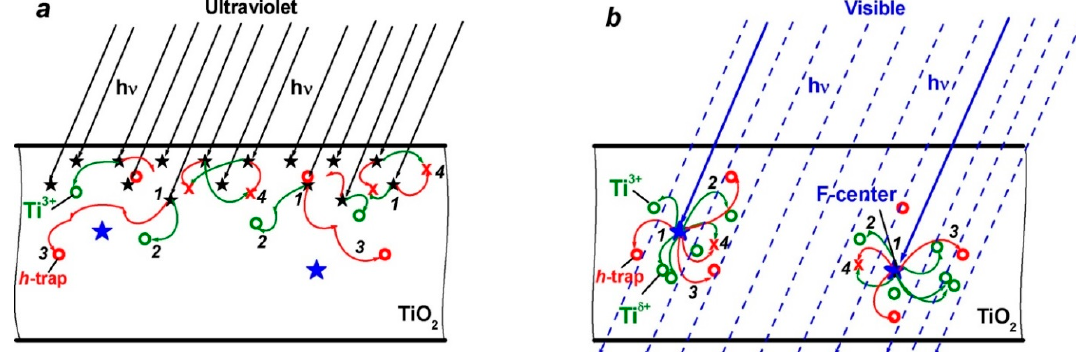
Figure 61. Illustration of the absorption of light quanta and formation of: ( 1 ) electron–hole pairs; ( 2 ) electron; and ( 3 ) hole transport and their localization at traps; together with ( 4 ) electron–hole recombination under: ( a ) UV irradiation; and ( b ) Vis-light irradiation of a microcrystalline particle of VLA TiO 2 . In ( a ), the black stars denote the photogenerated electron–hole pairs, the blue stars the F -type centers (electron trapped in oxygen vacancy); the green circles the Ti 3+ color centers, while the red circles refer to the trapped holes. In ( b ), the blue stars denote the F -type centers (electron trapped in oxygen vacancy), the green circles the Ti 3+ color centers, while the red circles denote the trapped holes. Note the Ti δ + centers in ( b ). Reproduced with permission from Kuznetsov et al. [70]. Copyright 2018 by Elsevier, B.V. (License No.: 4453641492289).